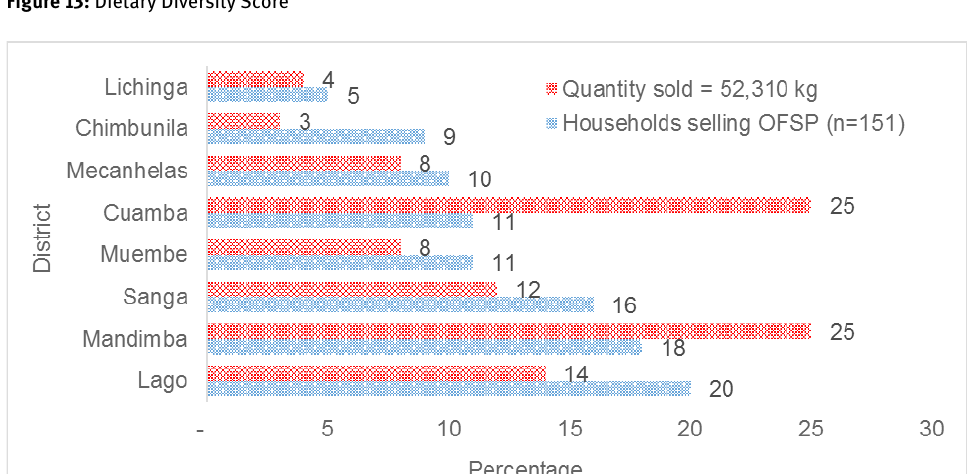
Figure 13: Dietary Diversity Score